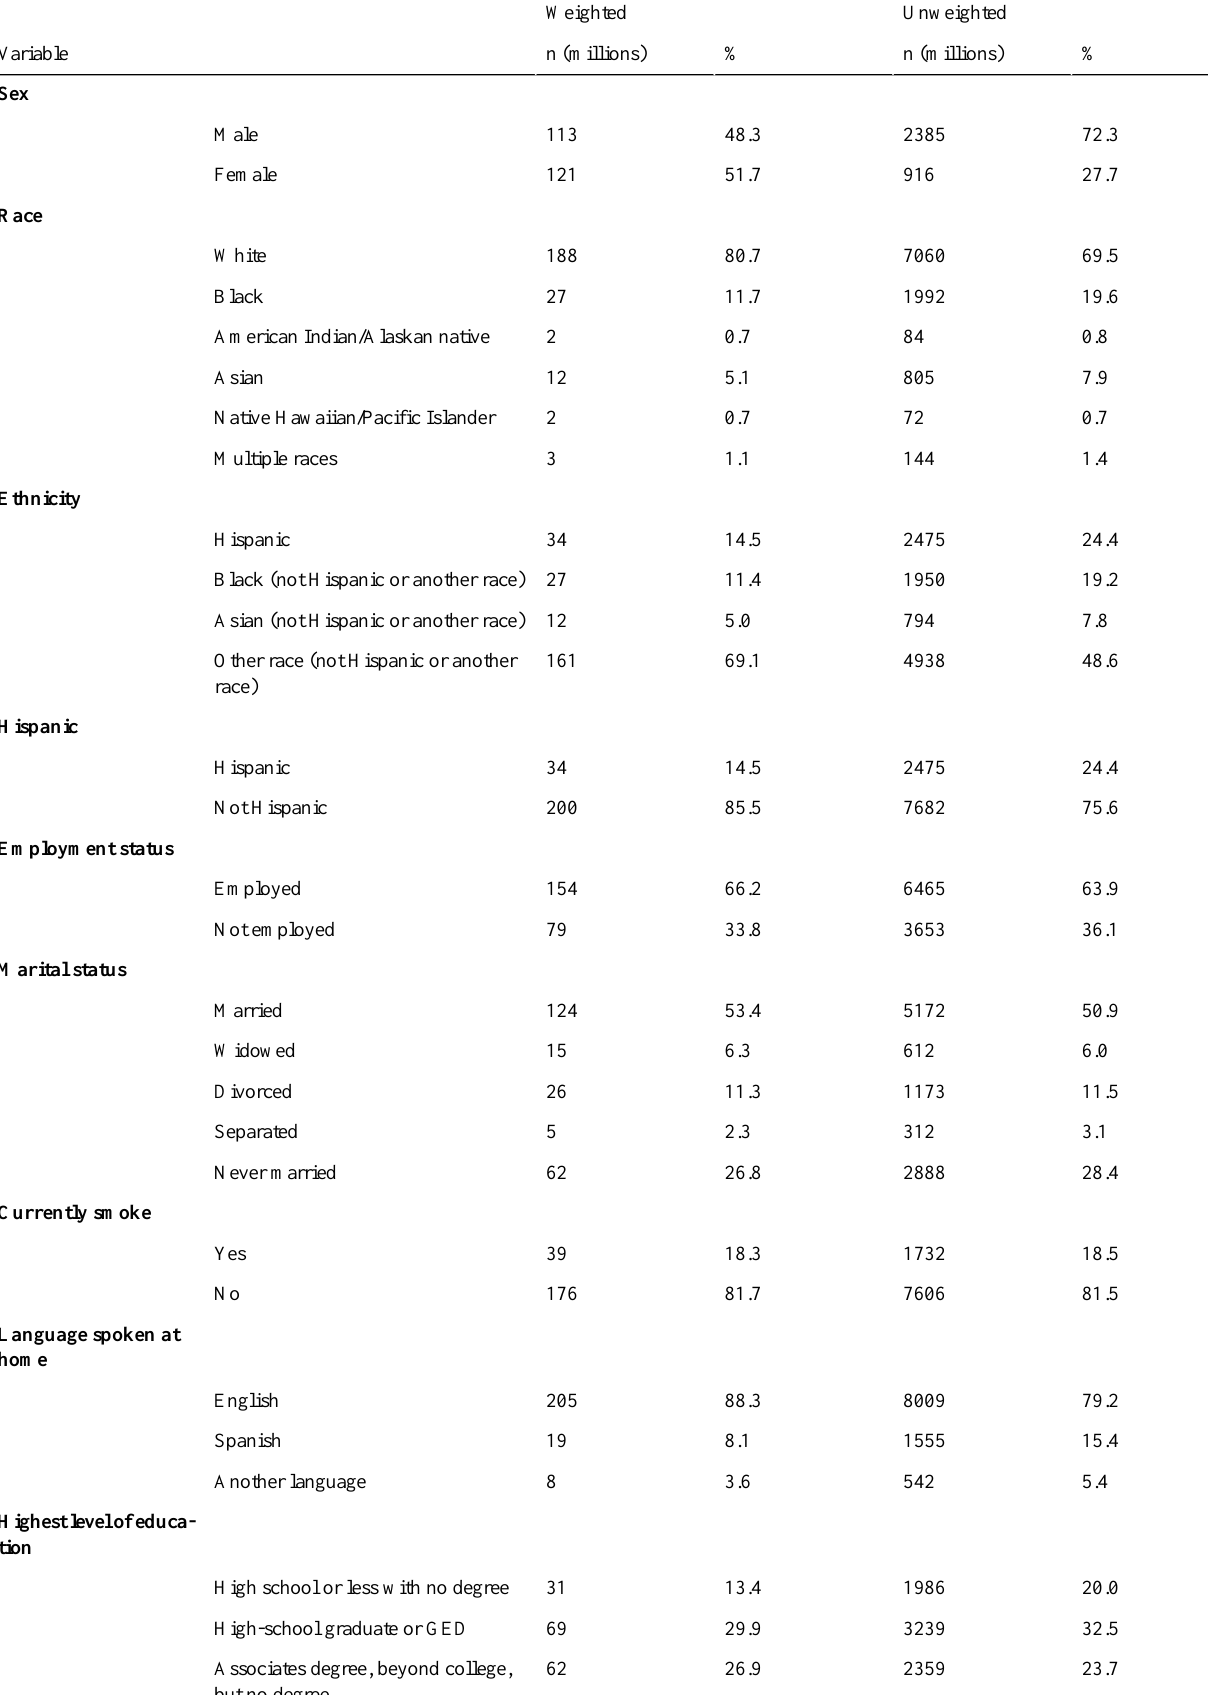
Table 1. Demographics of the sample from MEPS (weighted N=233.26 million; unweighted N=10,157).